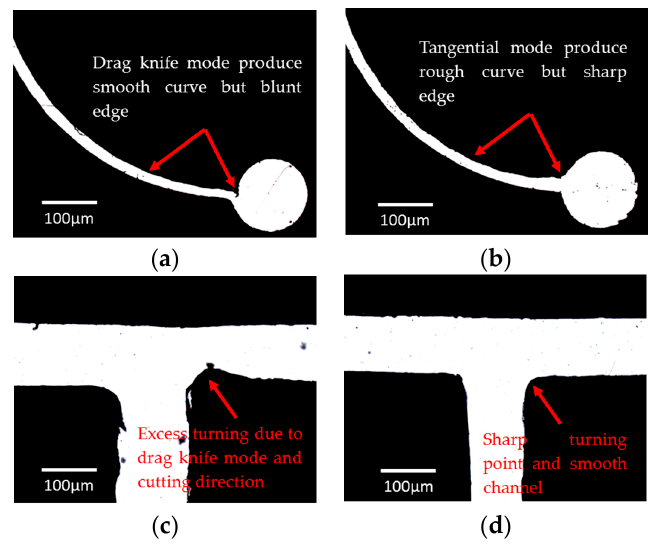
Figure 6. ( a ) Smooth channel curvature cut by the drag-knife mode. A clean cut near reservoir is harder to achieve in comparison to the tangential mode. ( b ) Rough channel curvature cut by the tangential mode with a cutting profile made of several straight lines with different angles. ( c ) Vinyl film with curvature at the corner by the drag-knife cutting even at the optimal offset value. ( d ) Clear edge cutting of the T-junction geometry by the tangential cutting.